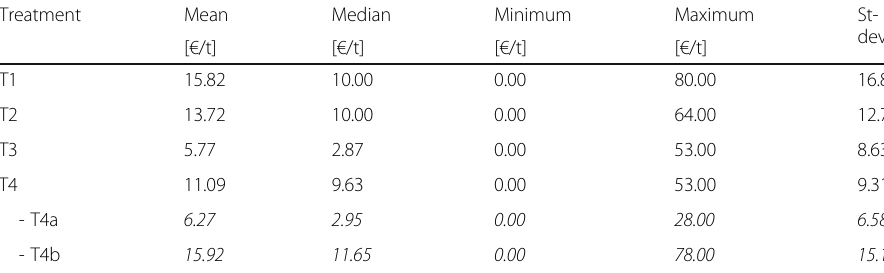
Table 4 Willingness to pay for digestate (Euro/ton) per treatment